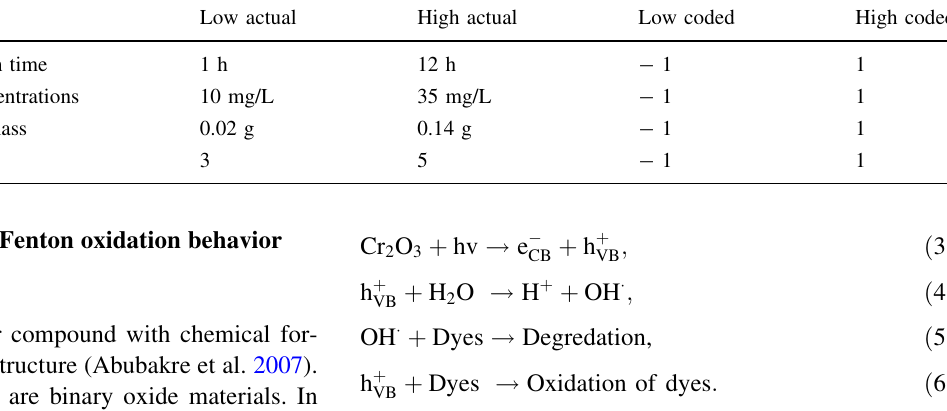
Table 1 The level and range of independent variables chosen for the removal of Congo red dye from aqueous solution Factor